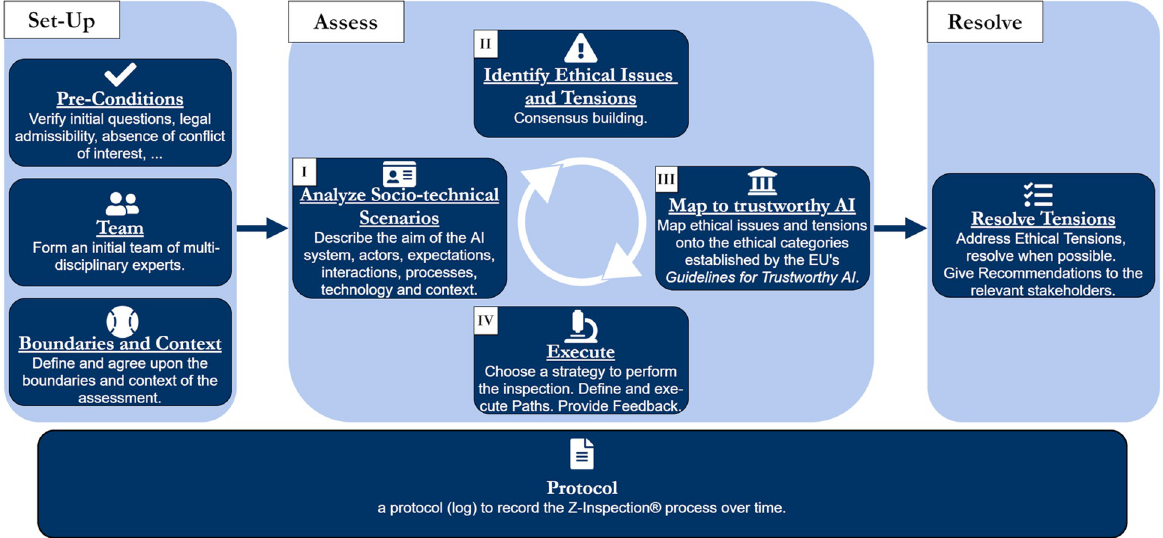
Fig 2. Z-Inspection 1 process. This figure has been reproduced from Zicari RV, Brodersen J, Brusseau J, Du¨dder B, Eichhorn T, Ivanov T, et al. Z-Inspection 1 : A Process to Assess Trustworthy AI. IEEE Trans Technol Soc. 2021 Jun;2(2):83–97. [56]